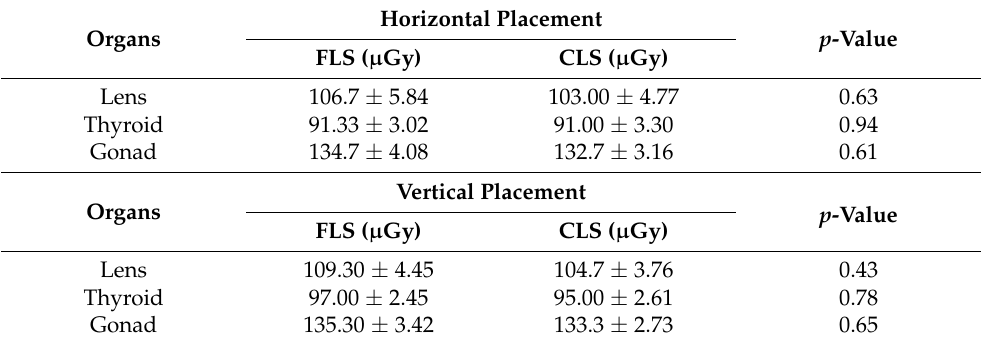
FLS: fogged lead glass shielding; CLS: clean lead glass shielding. Table 3. Organ doses of an operator with the shields placed at 20 cm away from image intensifier. Horizontal Placement Organs FLS ( µ Gy) CLS ( µ Gy) Lens